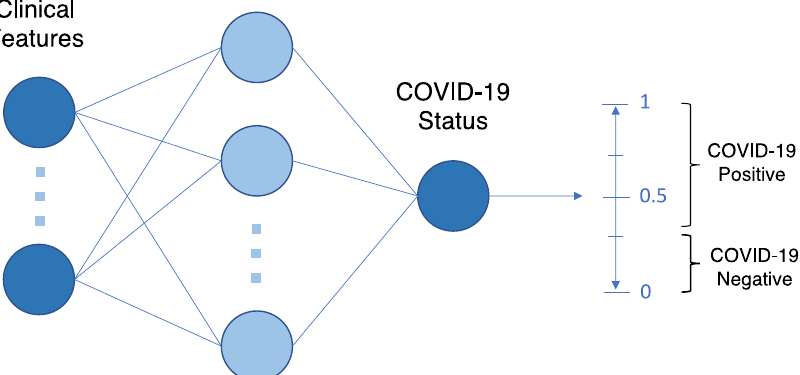
Fig. 3 Model architecture used for classi fi cation. Figure shows neural network architecture used for classi fi cation, including a visual of the decision boundary used to determine COVID-19 positive or negative